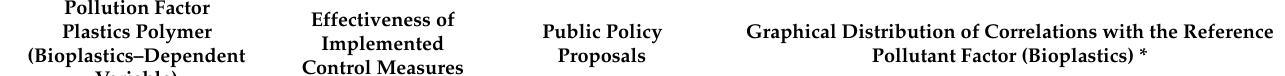
Table 5. Proposals for improving public policies in the field of combating water pollution caused by microplastics.